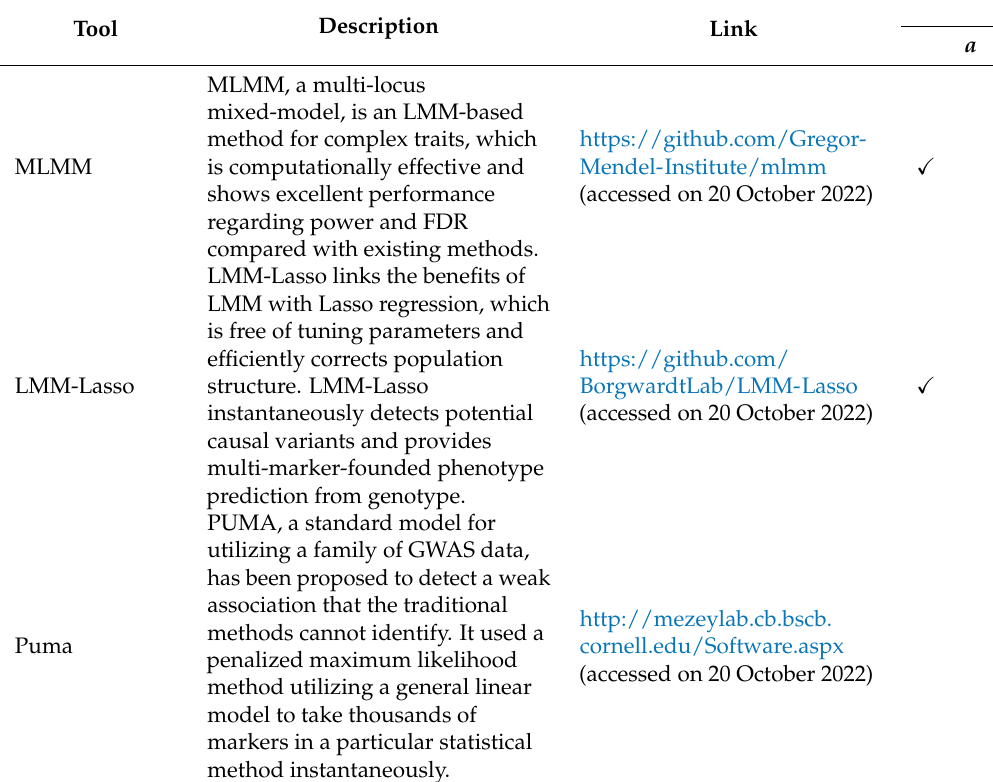
Table 2. Multi-locus models and their respective software and packages for GWAS using LMM.